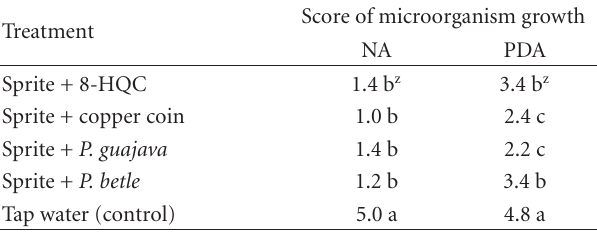
Table 3: E ff ect of vase solution containing 8-HQC, copper coin, leaf extracts of P. guajava , and P. betle and control at seven days after treatment on the microorganism growth after three days of inoculation. Media used were nutrient agar (NA) and potato dextrose agar (PDA). Score of microorganism Treatment